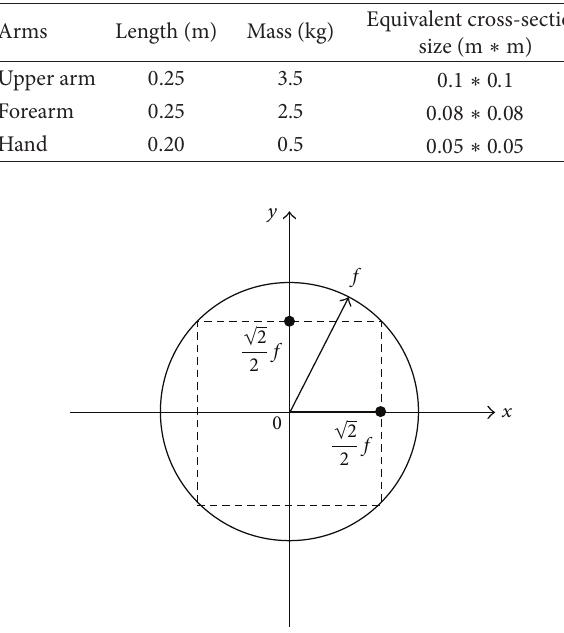
Figure 2: Linearization of transitional friction constraint.